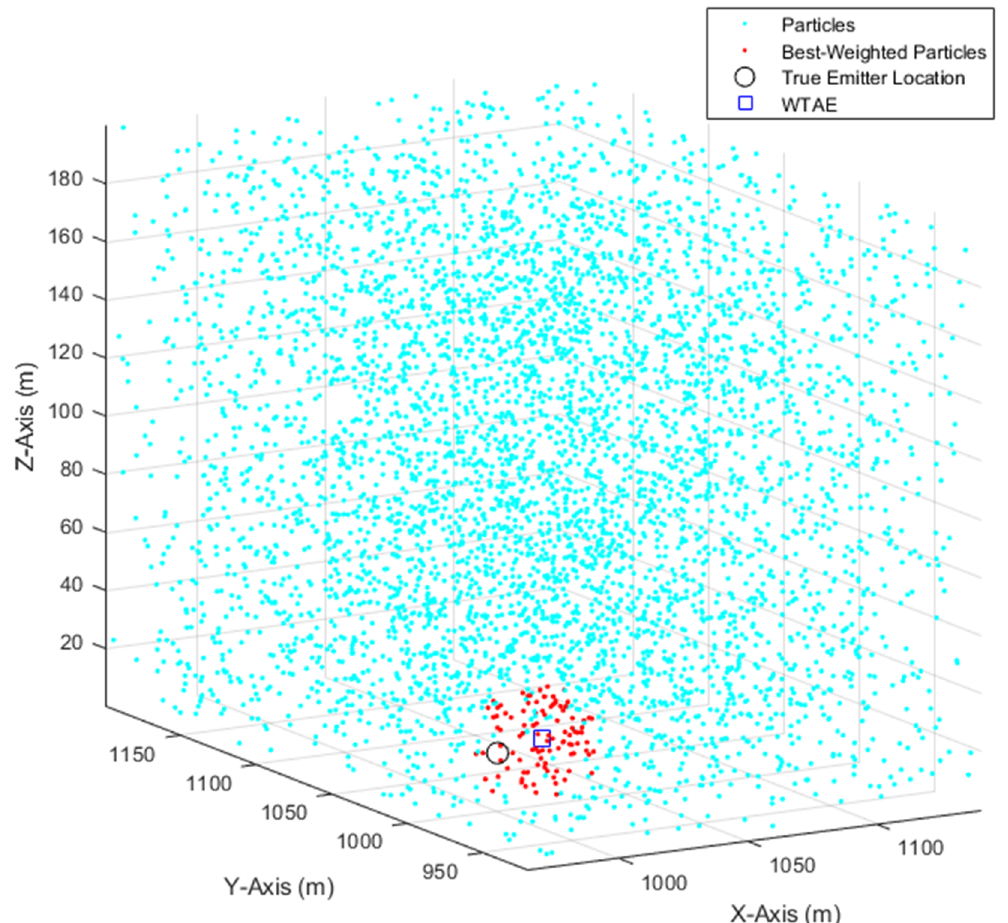
Figure 2. Illustration of the PF implementation.